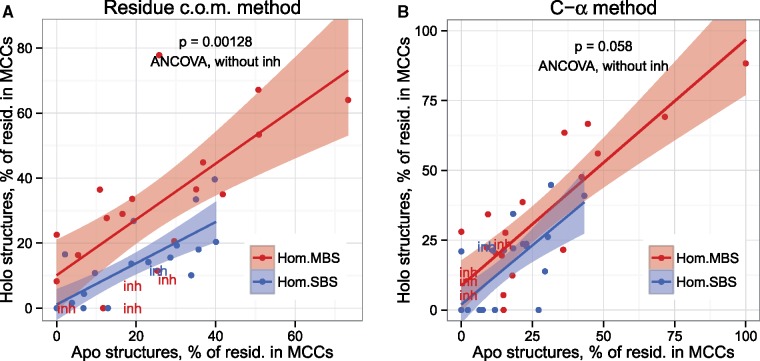
MBS and SBS homomers show different responses upon ligand binding. In SBS homomers, the number of residues in MCCs is reduced in the holo (ligand binding) structures, whereas in MBS homomers, their number is unchanged or slightly increased (ANCOVA, excluding structures with inhibitors. P indicates the significance of the categorical—binding site type—variable). Structures with inhibitors are indicated with “inh.” The residue c.o.m. method (A) indicates a significant difference, but not the C-α method (B). Additionally, in the case of residue c.o.m. method, structures crystallized with inhibitors (thus the ligand-binding form is their inactive form) are distinct from structures crystallized with their orthosteric ligands or activators, supporting the conclusions of VanWart et al. (2012), that the residue c.o.m. method is better in identifying biologically relevant residues in allosteric proteins.